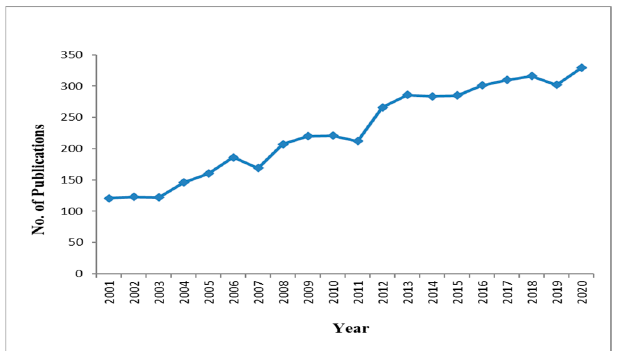
Figure 2. Publications on nematode identification as per PUBMED (Query: Molecular markers, DNA barcoding).